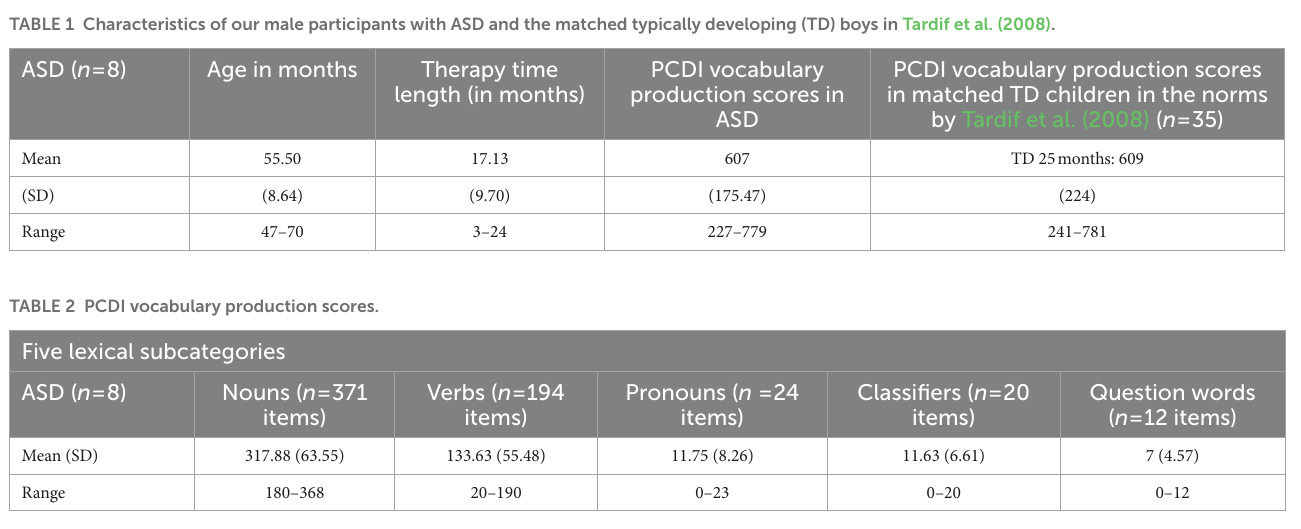
TABLE 3 Mean length of utterance (SD) and sentence complexity scores of our male participants with ASD and the matched typically developing (TD) boys in Tardif et al. (2008). Grammatical